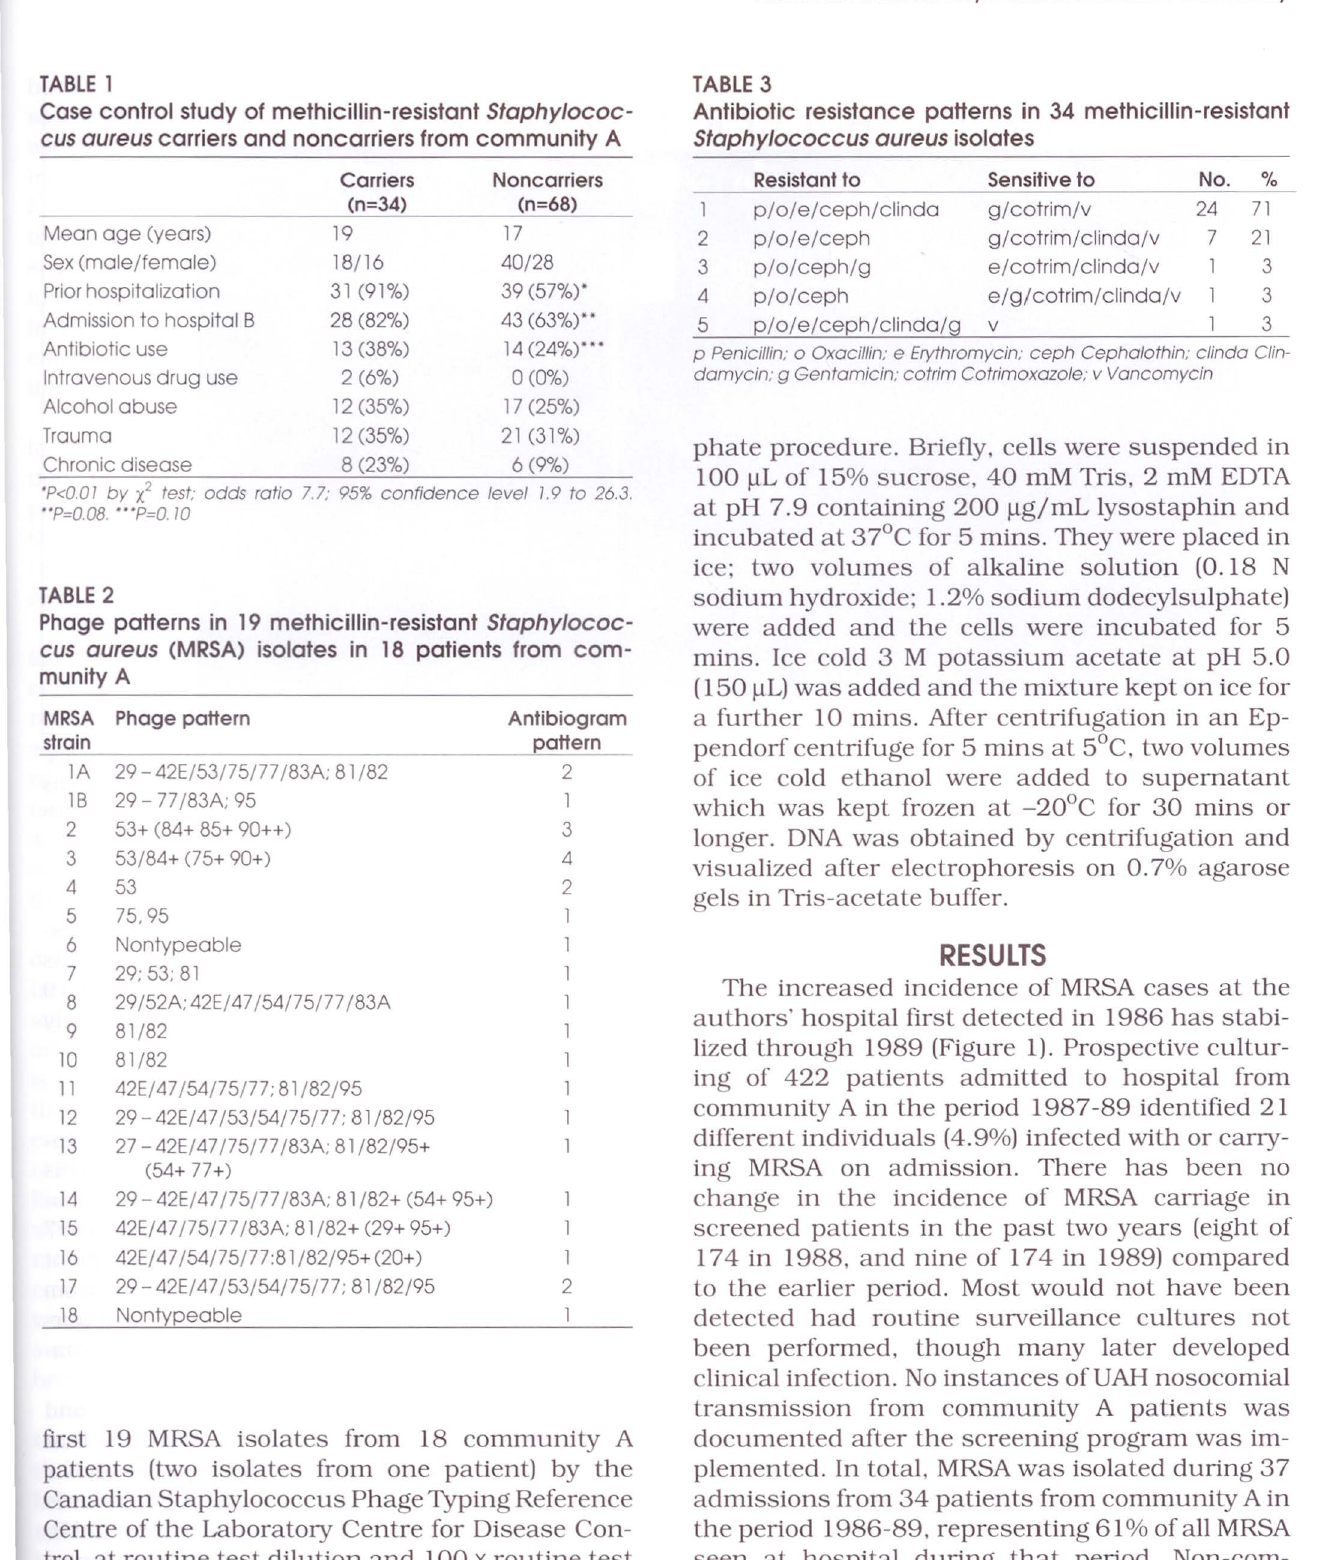
Case control study of methicillin-resistant Staphylococ cus aureus carriers and noncarriers from community A